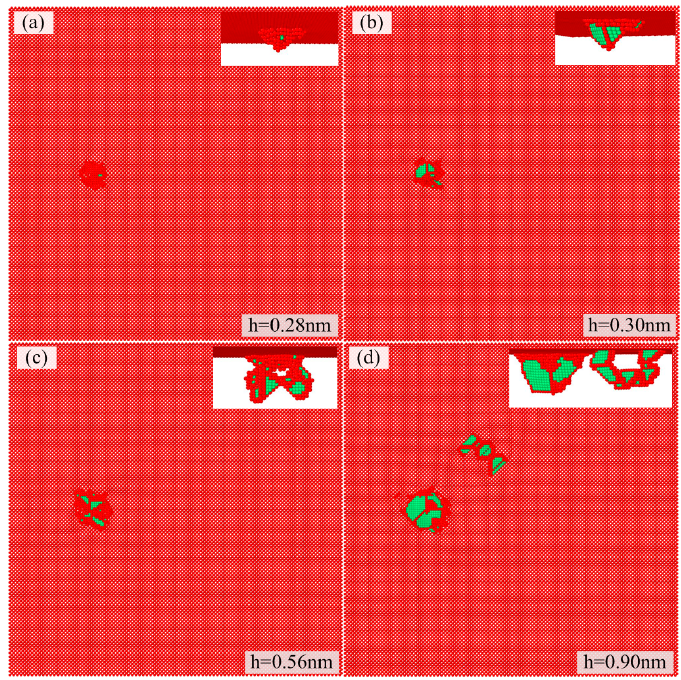
Figure 10. Atom configuration during indentation process with residual compress stress λ = − 0.17 at various indentation depths: ( a ) 0.28 nm; ( b ) 0.30 nm; ( c ) 0.56 nm; ( d ) 0.90 nm.. The green color shows stacking faults.